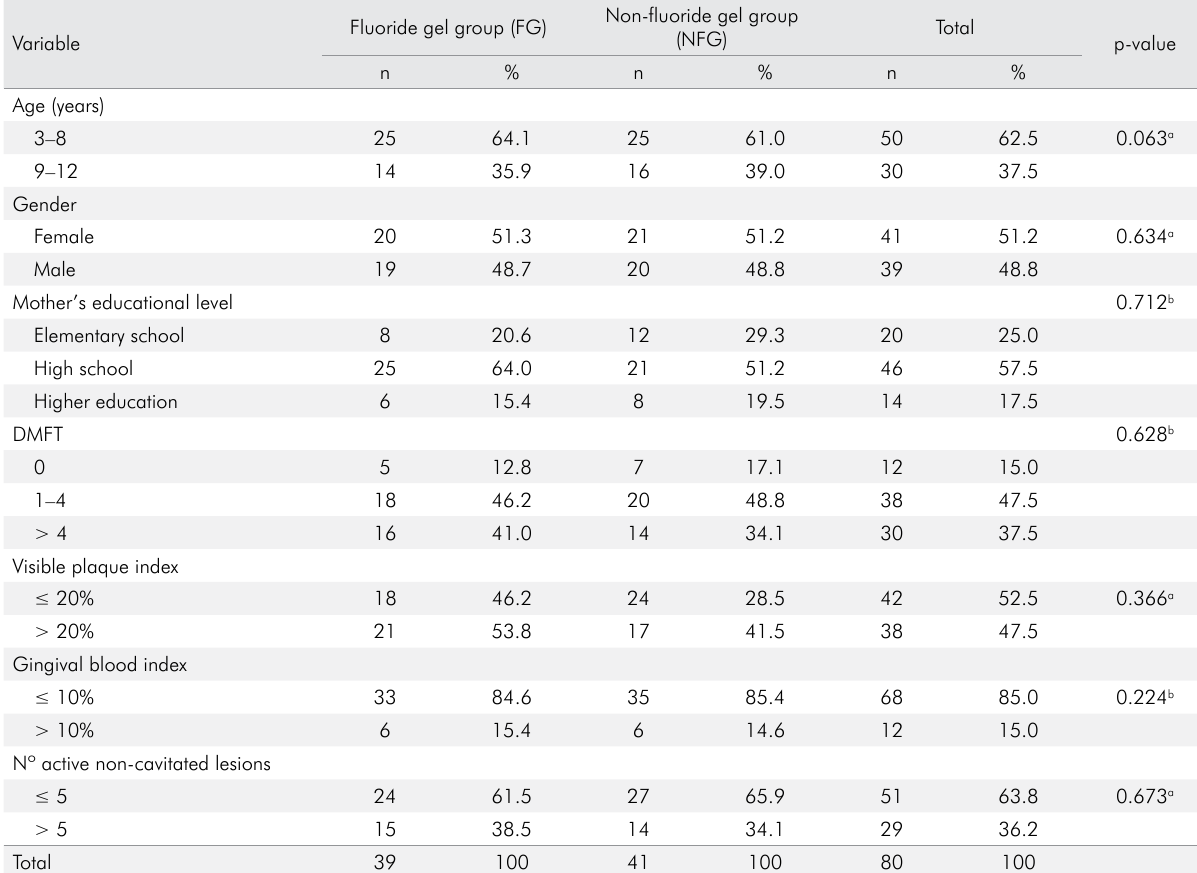
Table 1. Baseline characteristics by treatment